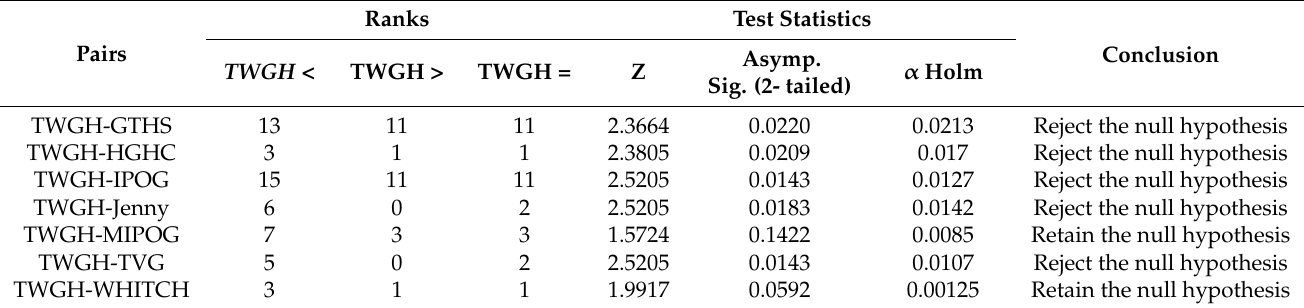
Table 9. Analysis of data from Table 6 using the Wilcoxon signed-rank sum